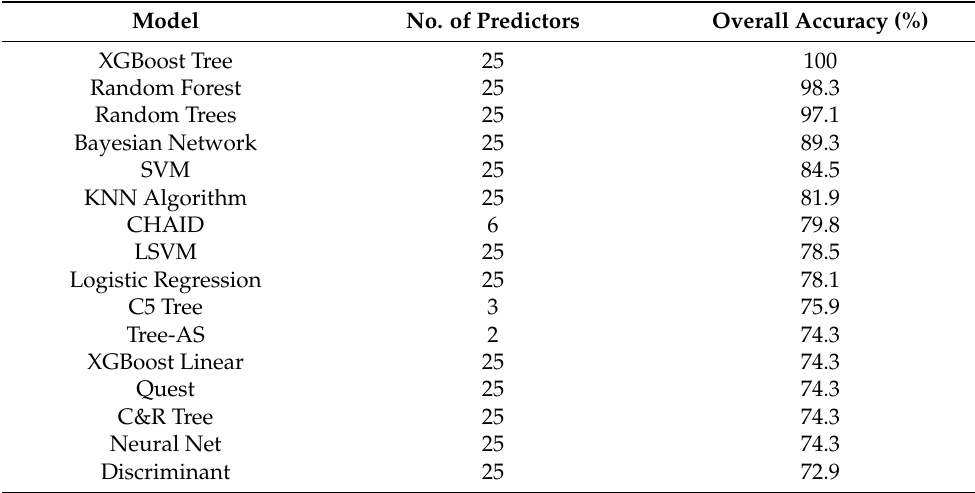
Table 2. Machine learning and artificial neural network analysis using gene expression